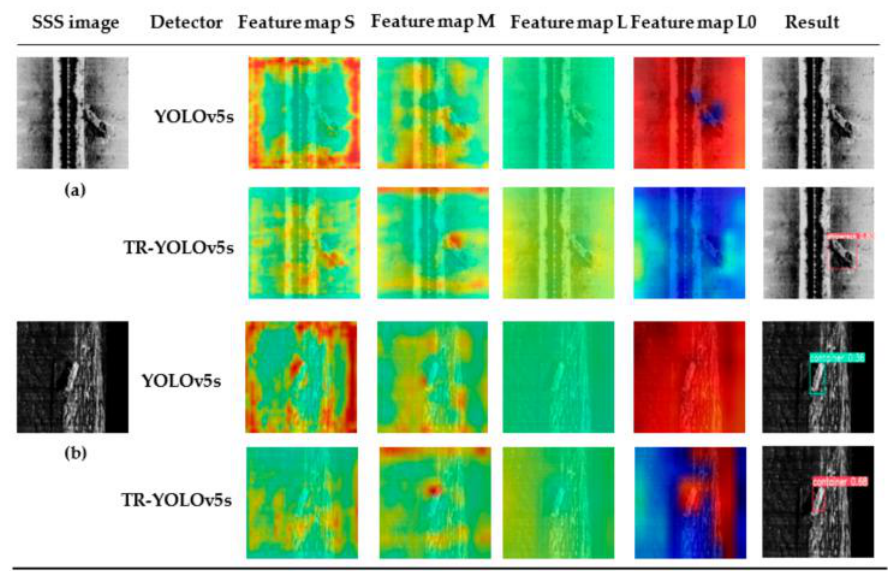
Figure 19. Comparison of the feature maps and recognition results of the shipwreck target in ( a ) and the container target in ( b ) between YOLOv5s and TR–YOLOv5s. The feature map S and M are from the antepenultimate and penultimate C3 modules (Figure 6) for detecting small and medium targets. The feature maps L and L0 are from the last C3 modules for detecting large